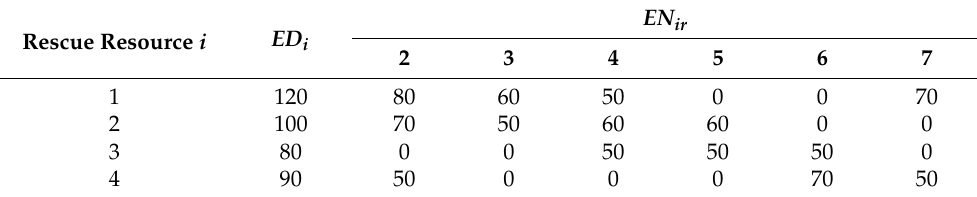
Table 5. The maximum tolerable transport time and the assembly time of each rescue center. Rescue Resource i